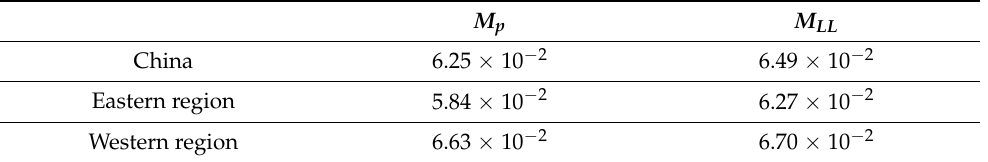
Figure 5. Out-of-sample forecasts for China and two regions for 2015. Table 2. RMSE of proposed model M p and Li–Lee model M LL for forecasts to 2015.